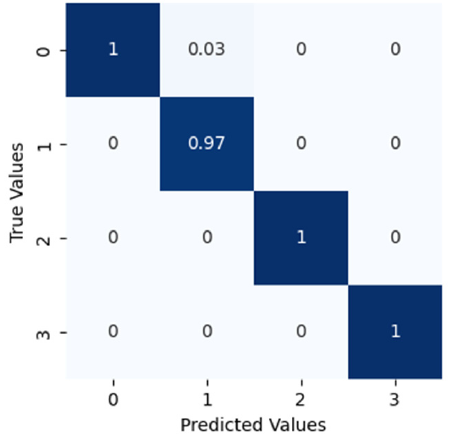
Figure 17. The confusion matrix for this classification.